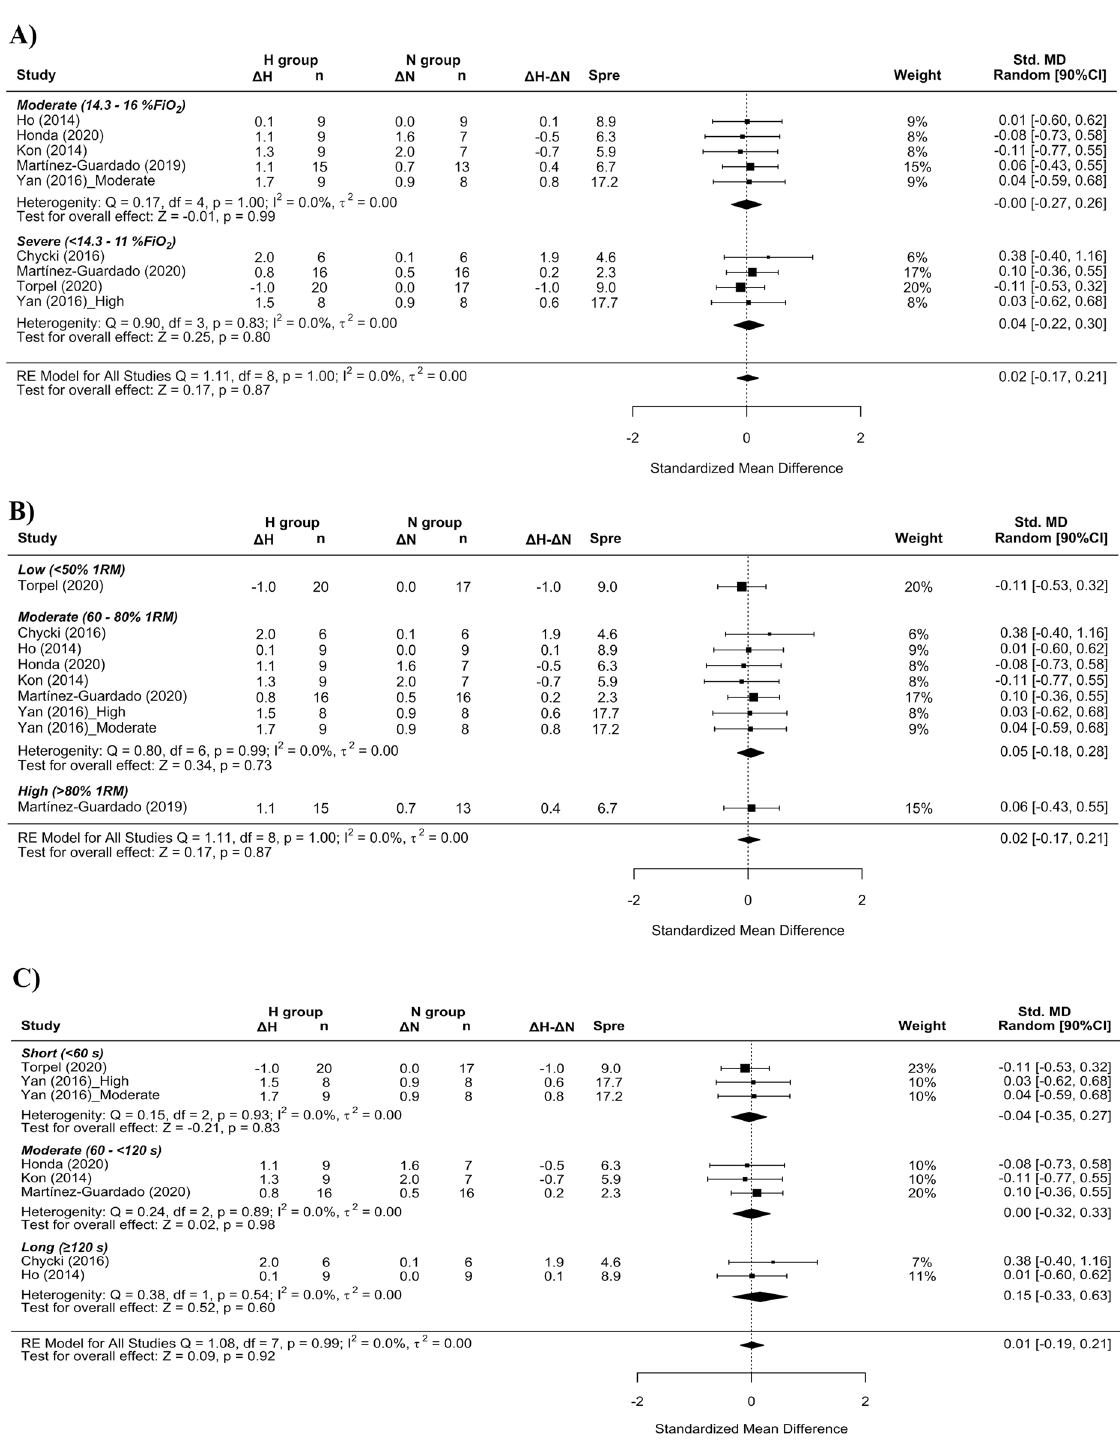
Figure 5. Forest plot of the standardized mean differences of the resistance training program between- conditions (hypoxic [H] group vs. normoxic [N] group) on lean mass subanalysed by: ( A ) severity of the hypoxia; ( B ) training load; and ( C ) interset rest interval. Δ: mean differences between post–pre in H and N or between H–N; n: sample size; Spre: mean baseline standard deviation; Std. MD: standard mean difference; RE: random effect’s model; CI; confidence interval; FiO 2 : fraction of inspired oxygen; 1RM; 1 repetition maximum; Q: test statistic for the test of heterogeneity; df: degrees of freedom; p : p value; I 2 : I 2 test; τ 2 : tau 2 test; Z: z value. Yan et al. 44 study provides a group with moderate hypoxia and another with high